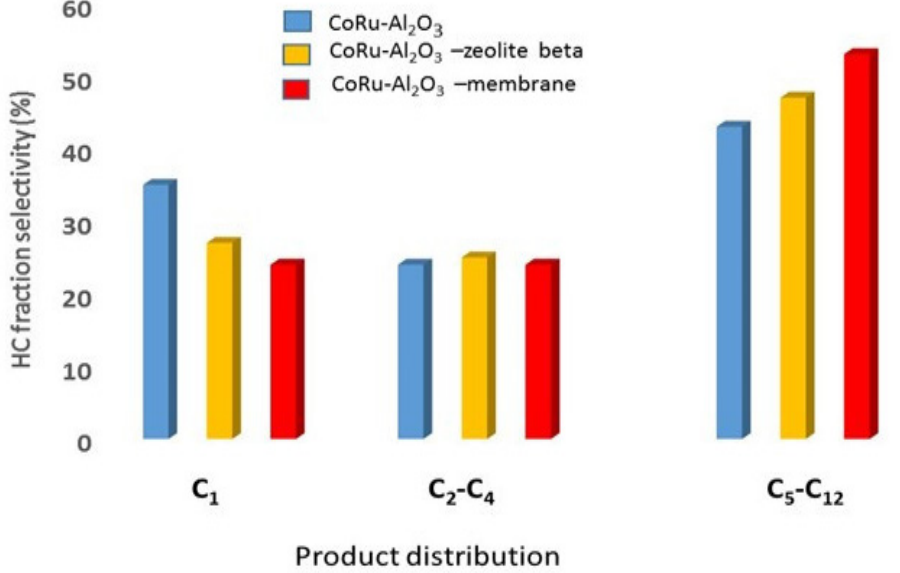
Figure 5. Hydrocarbons (H.C.) fraction selectivity versus the product distribution for three experi- ments after 15 h on stream (XCO ≈45%).